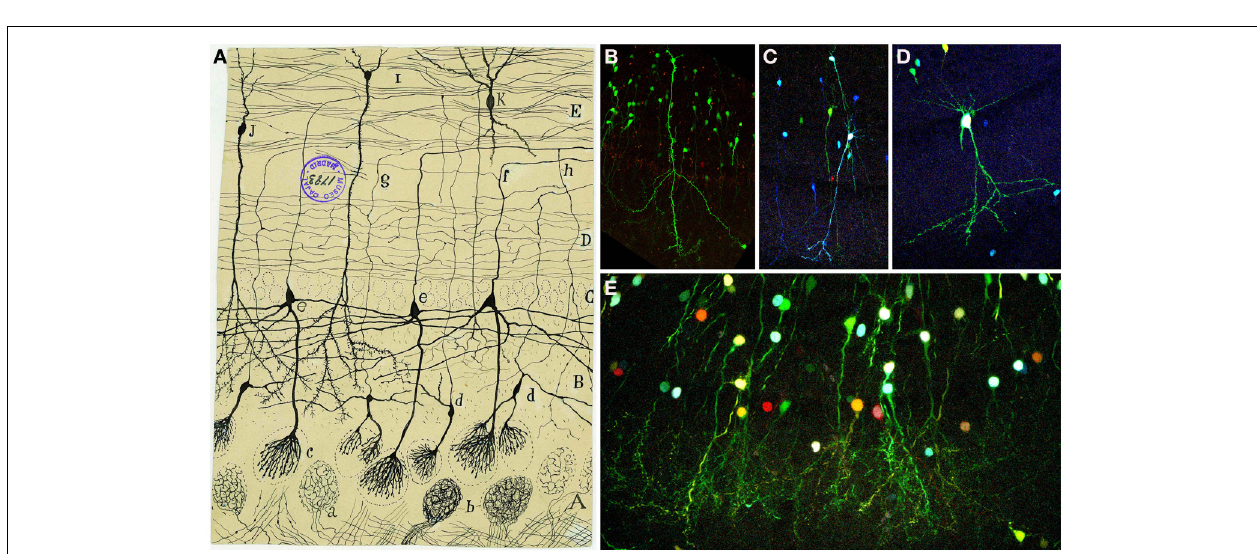
Spain). (B) Mitral cells labeled after BDA injection into the lateral olfactory tract at P5 (Blanchart et al., 2006). (C) Retrograde labeling of mitral cells after DiI injection into the lateral olfactory tract at E17 (Blanchart et al., 2006).